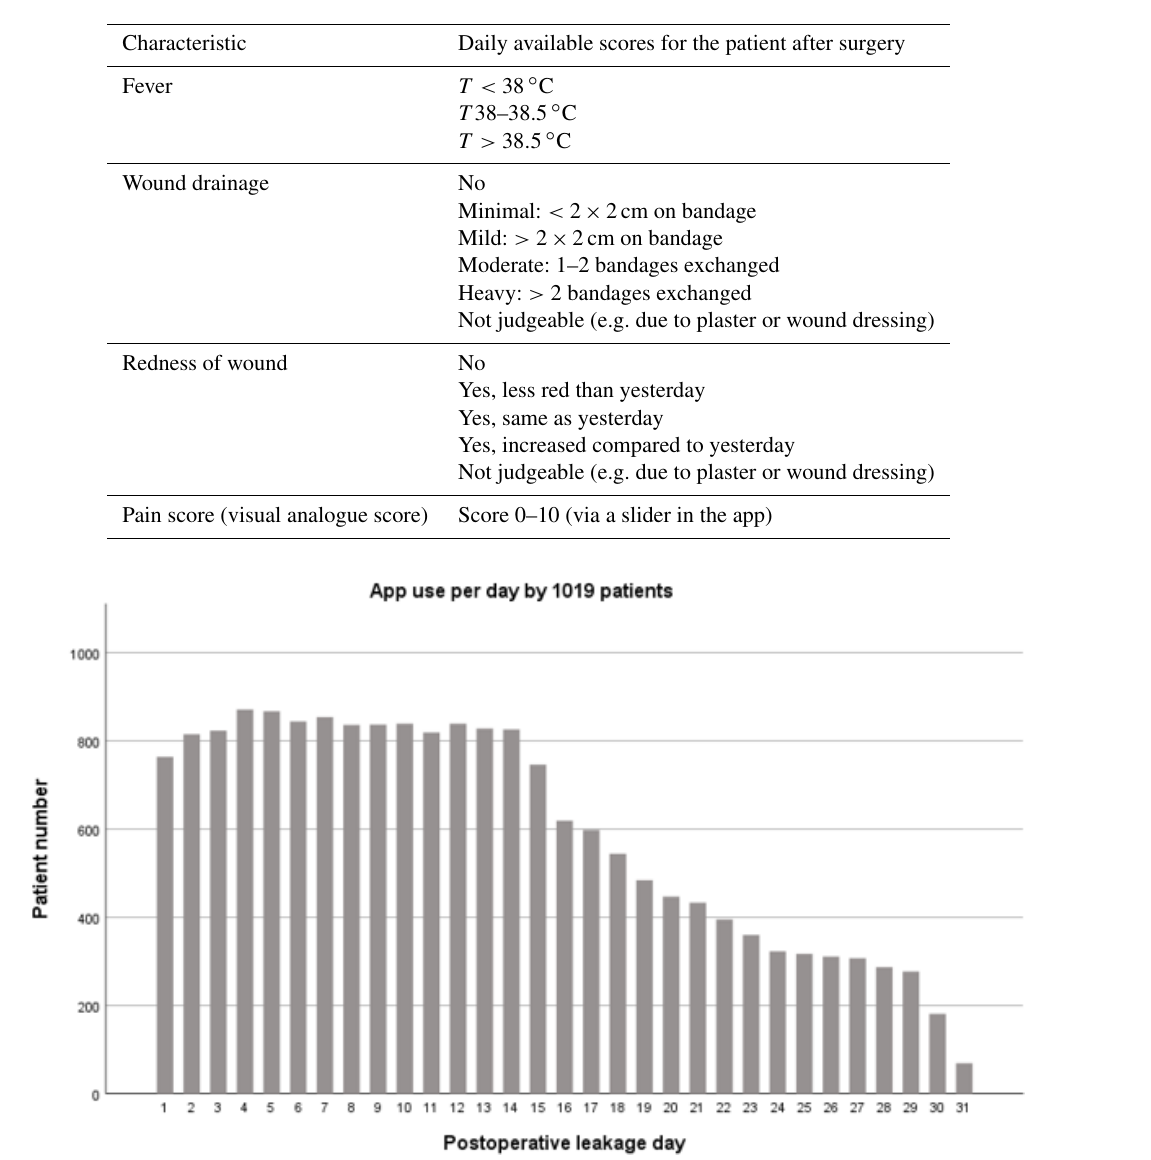
Table 1. Self-reported wound characteristics by patients in the wound care app.